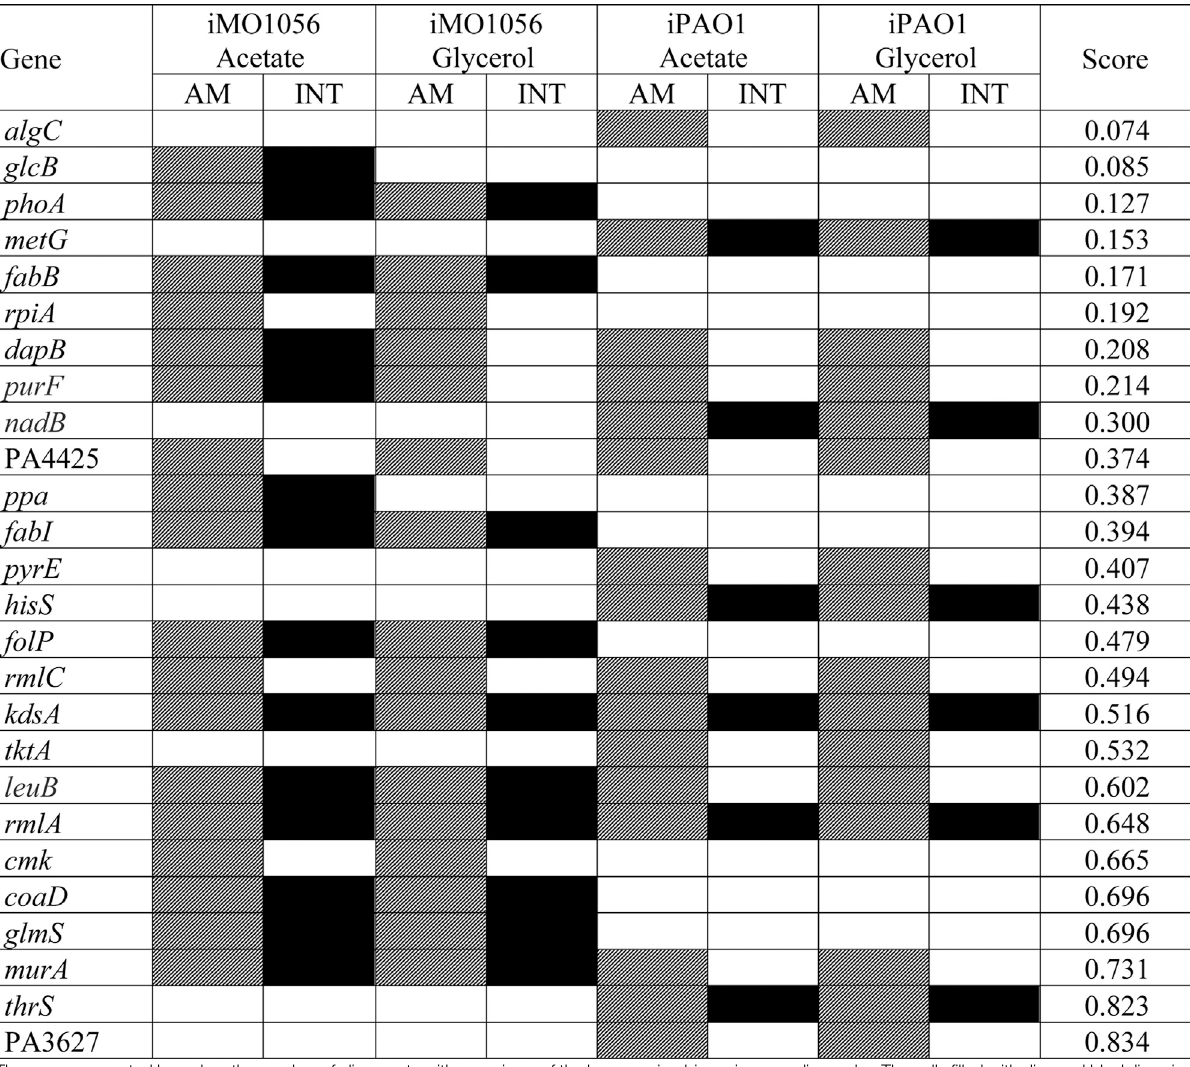
The genes are sorted based on the number of alignments with organisms of the human microbiome in ascending order. The cells fi lled with diagonal black lines indicate the target was identi fi ed from the metabolic models with adjusted carbon sources uptake rate (AM). The cells fi lled with full black color indicate the target was identi fi ed from the integrated models